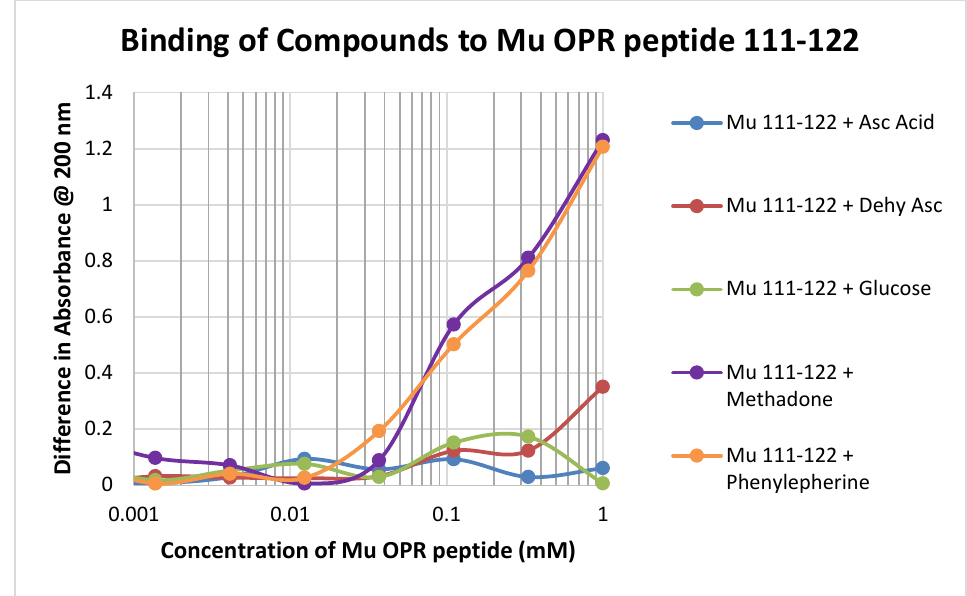
Figure 5. Binding of various compounds to the muOPR peptide 111–122. The observed lack of significant binding was typical of all of the peptides lacking cysteine residues (see Figure 1 and Table 1). In contrast to the relative lack of binding to the muOPR peptides 111–122 and 121–131, muOPR 132–143 displayed significant binding to ascorbic acid but not dehydroascorbic acid, and adrenergic compounds such as phenylephrine and L-DOPA (Figure 6; see also Table 2). Notably, this peptide also bound opioid compounds such as methadone (Figure 6) as well as morphine, naloxone and met-enkephalin (Table 2).